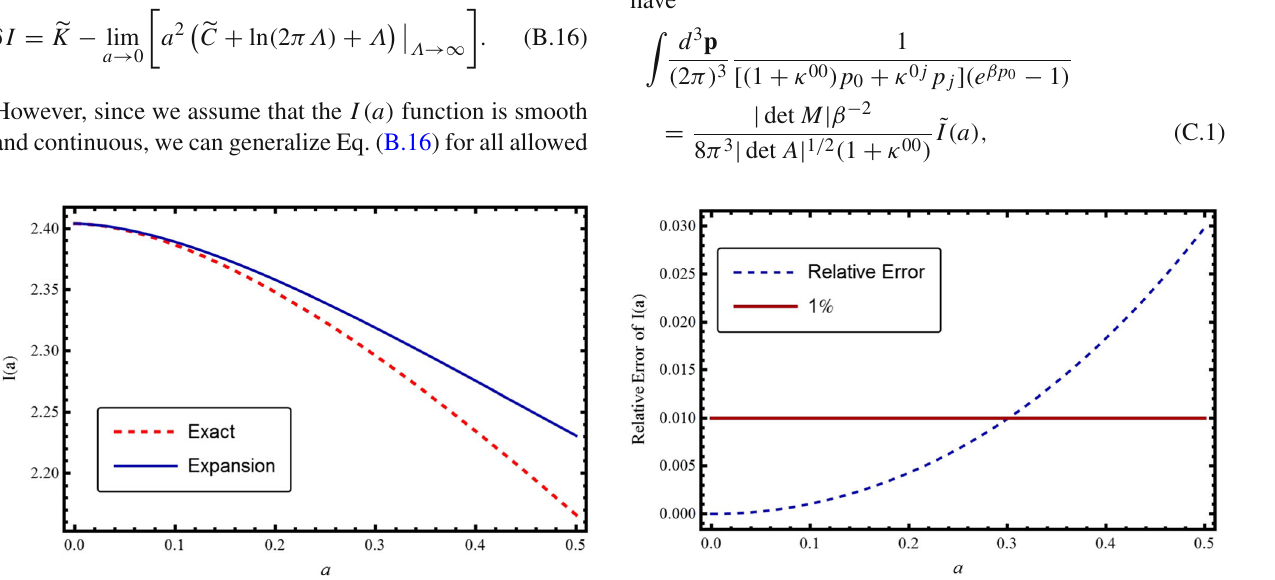
Fig. 1 On the left, we have plotted the values of the integral both exact numerical calculation (red dashed line) and the approximation (blue continuous line). On the right, we have plotted the relative error of